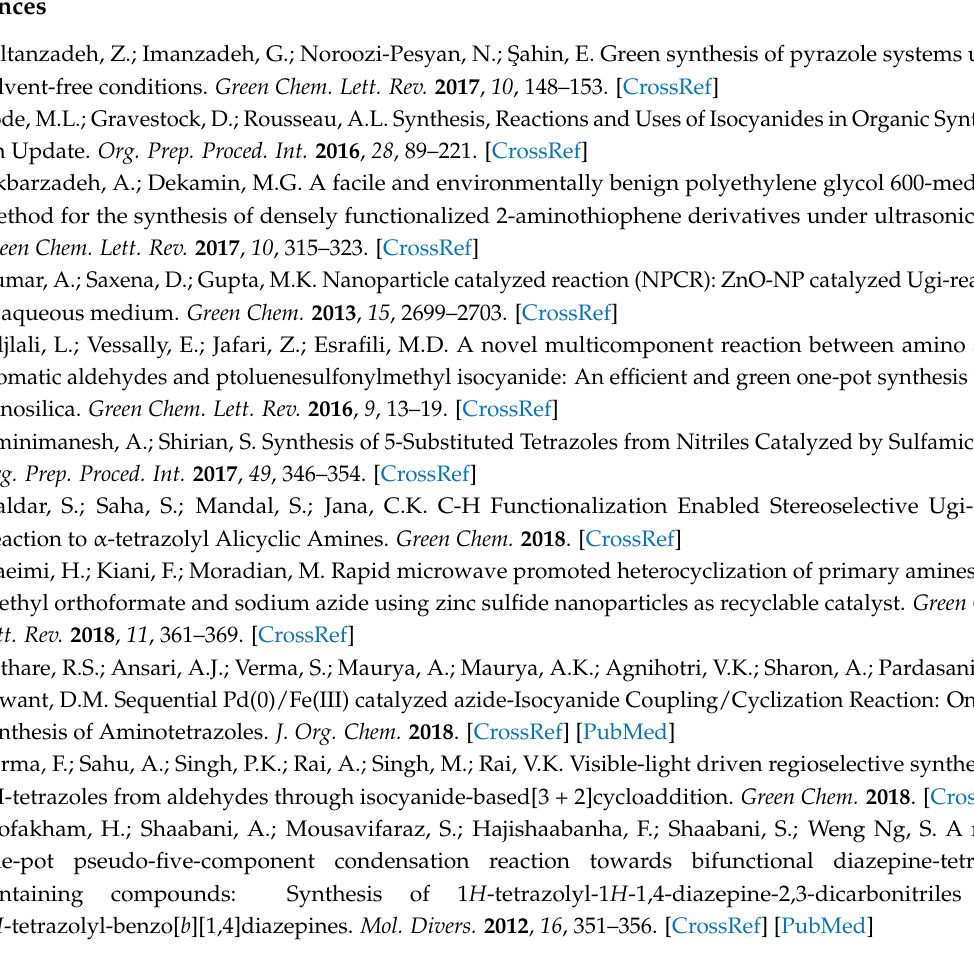
Supplementary Materials: The following are available online. 1 H and 13 C-NMR spectra of all the products 1 – 4 Figures